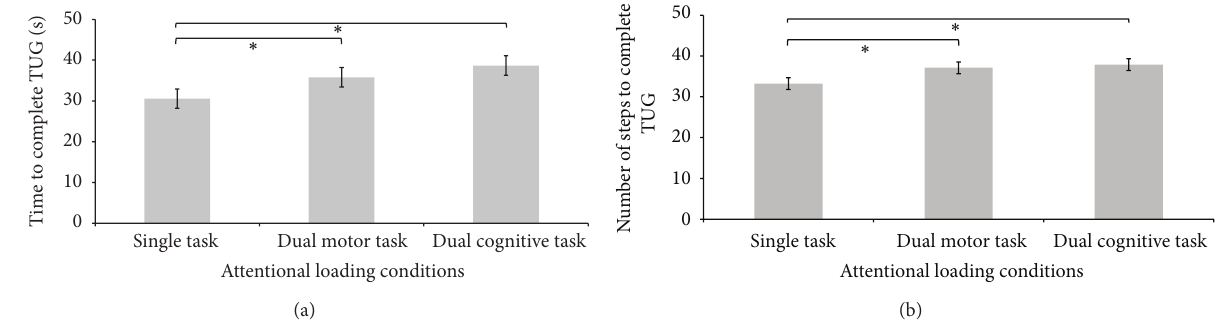
Figure 2: Comparison of gait performance under three attentional loading conditions in stroke survivors. (a) Time to complete TUG. (b) Number of steps to complete TUG. Asterisks ( ∗ ) signify statistically significant differences ( 𝑃 < 0.05 ). Error bars represent standard error.